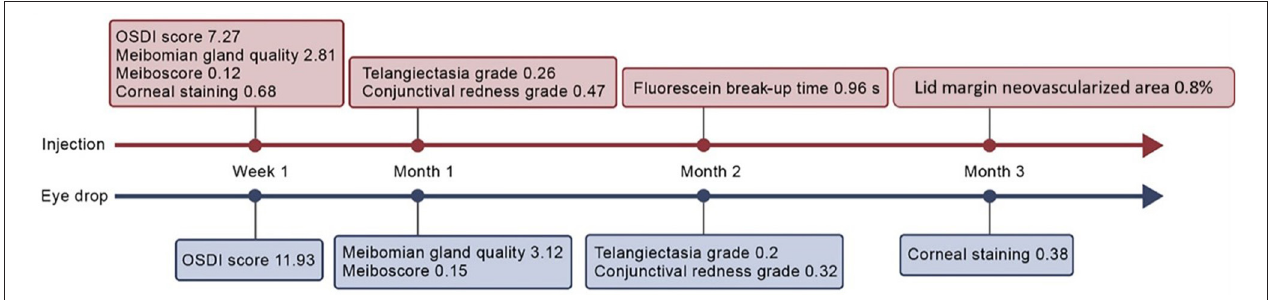
FIGURE 5 | Anticipated clinically significant improvements for the eight